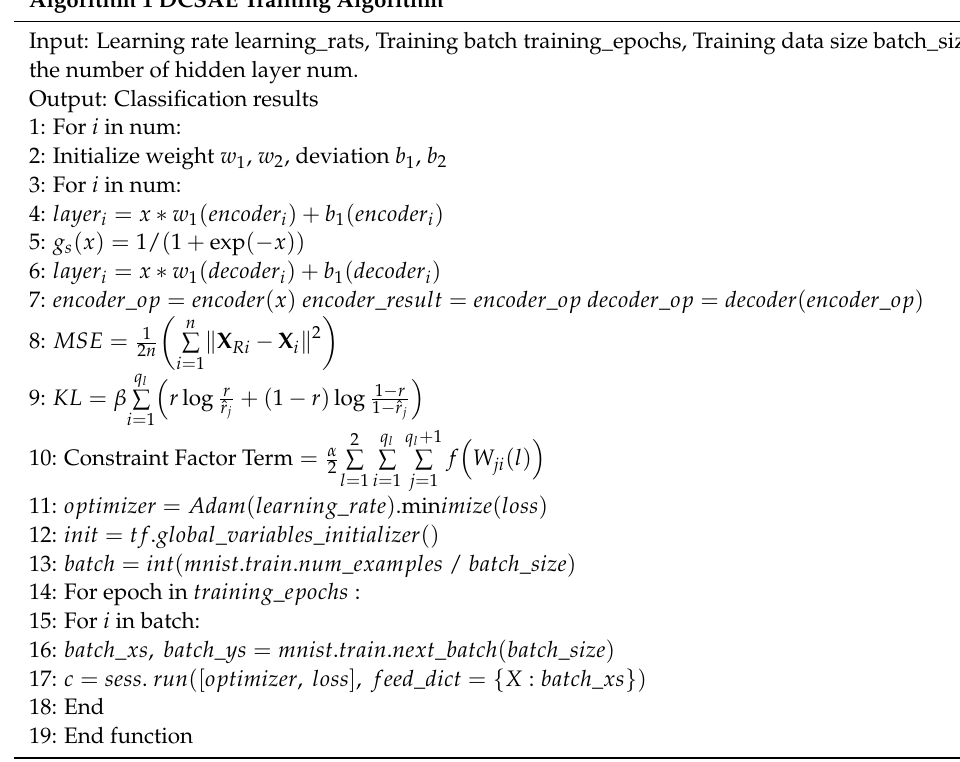
Algorithm 1 DCSAE Training